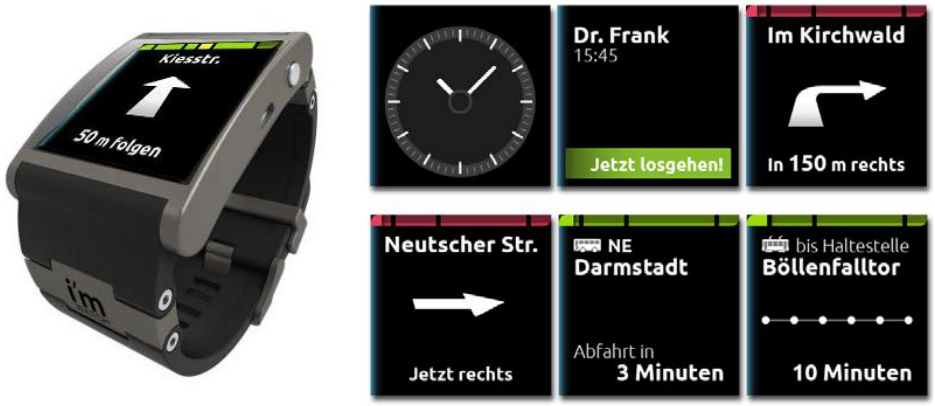
Figure 6. Smart armband prototype.